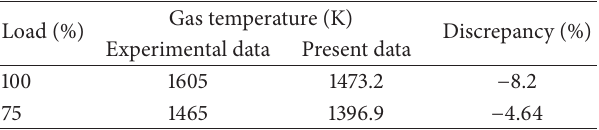
Table 5: Comparison of the calculated furnace exit gas temperature with the measured data.